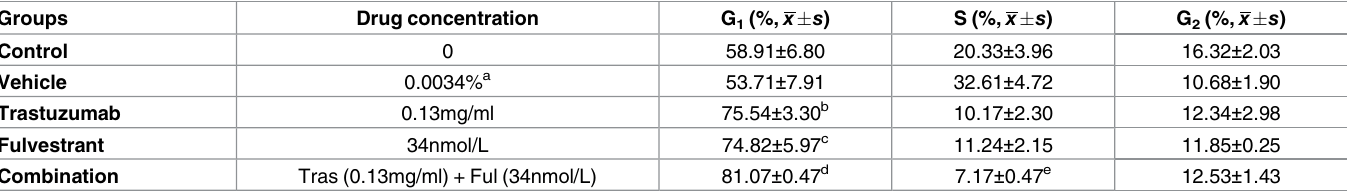
Table 5. Effects on the cell cycle progression of BT-474 cells treated with trastuzumab or fulvestrant or with a combination of both. Groups